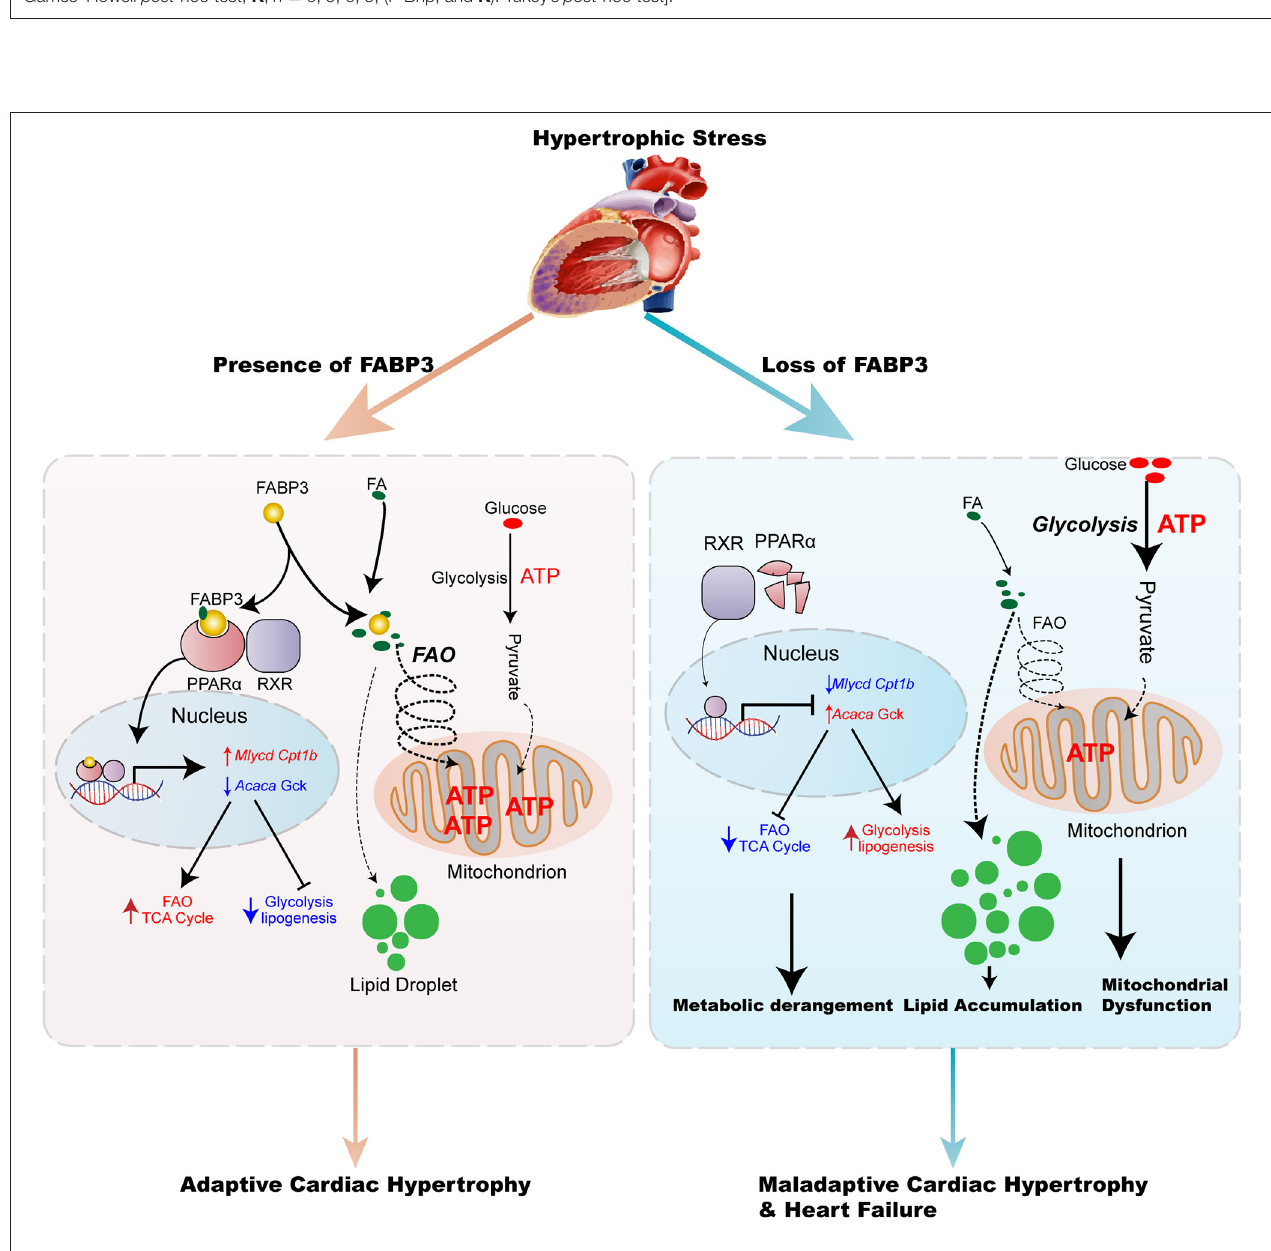
FIGURE 8 | Model of the FABP3-mediated PPAR α pathway in cardiac metabolic reprogramming and progression of cardiac hypertrophy and heart failure. The schematic demonstrates that the FABP3-mediated PPAR α pathway regulates cardiac metabolic reprogramming by directly interacting with PPAR α , thereby stabilizing and inducing its transactivation, which triggers downstream Mlycd and Cpt1b gene expression, while suppressing Acaca and Gck gene expression. This results in increased FAO levels and mitochondrial ATP production, ultimately resulting in adaptive cardiac function. However, in mice lacking FABP3, the response of FABP3-mediated PPAR α on FAO/Glycolysis balance is abolished, and leads to the degradation of PPAR α , lower transcriptional activity on FAO genes accompanied by increased lipogenesis, and glycolysis gene expression, which contributes to the increase in the glycolysis rate, accumulation of toxic lipid species, and compromised mitochondrial ATP production, thereby aggravating the progression of cardiac hypertrophy and heart failure.